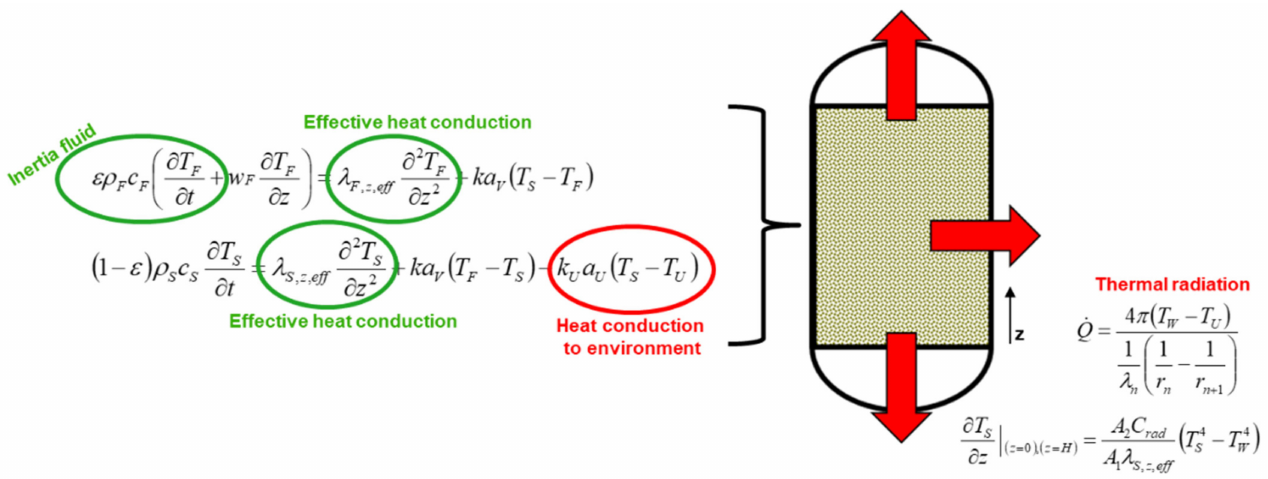
Figure 11. Model extension to include heat loss effects and inertias for solid media heat